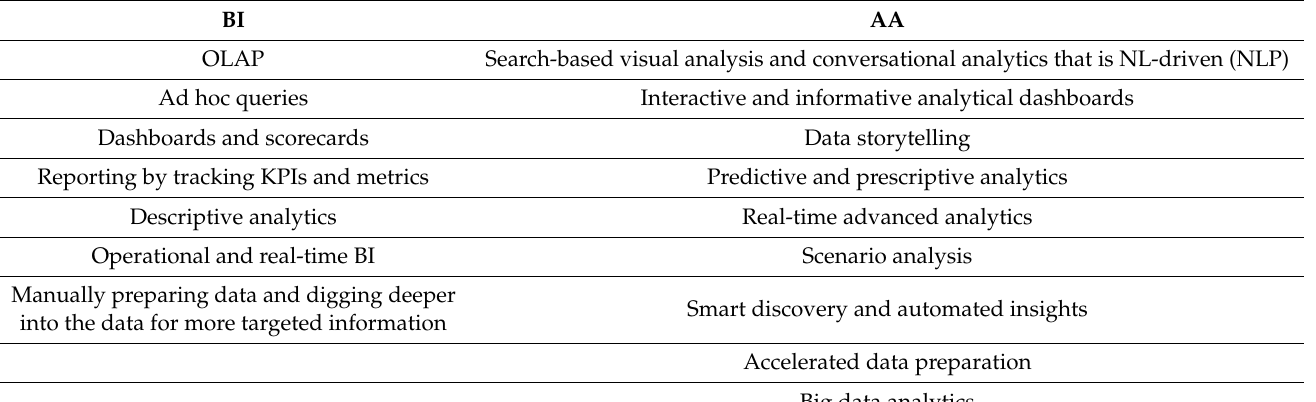
Table 1. Expanded features of AA compared to features of classical BI.